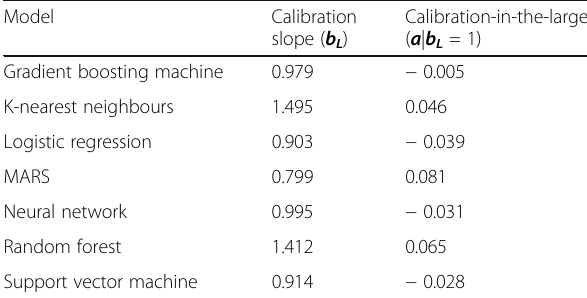
Table 3 Calibration test results on external validation dataset. Calibration-in-the-large indicates whether predicted probabilities are, on average, too high (value below 0) or too low (value above 0). Conversely, the calibration slope quantifies whether predicted risks are, on average, too extreme (value below 1) or